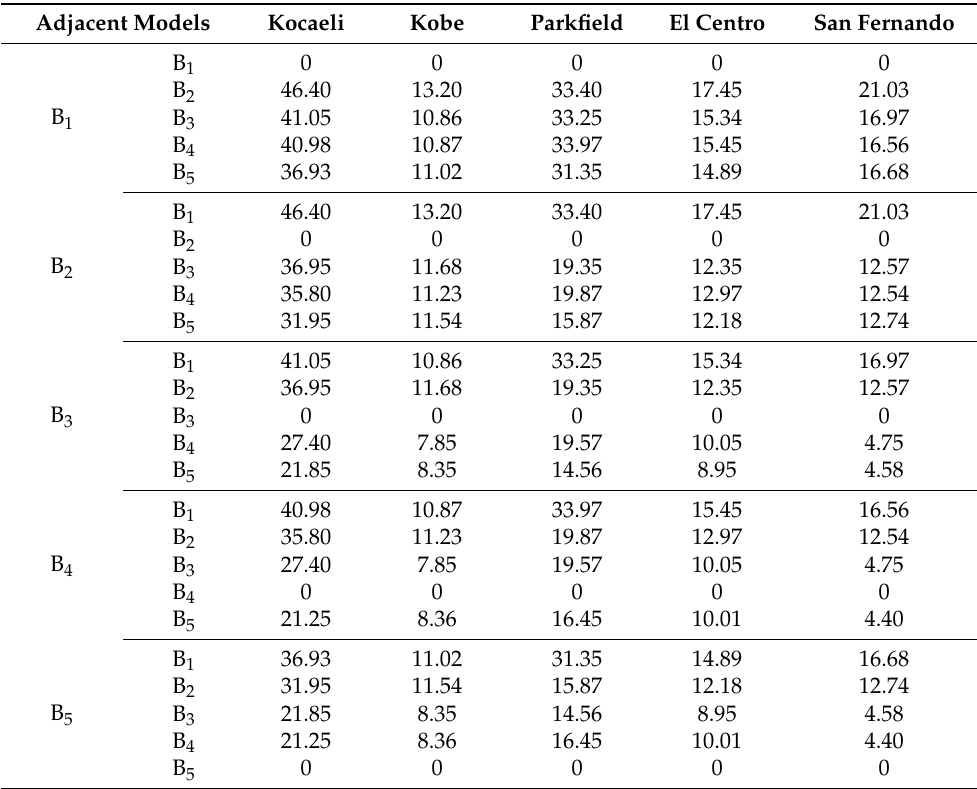
Table 5. Estimated separation distance using the CRVK program for different models under various ground motions